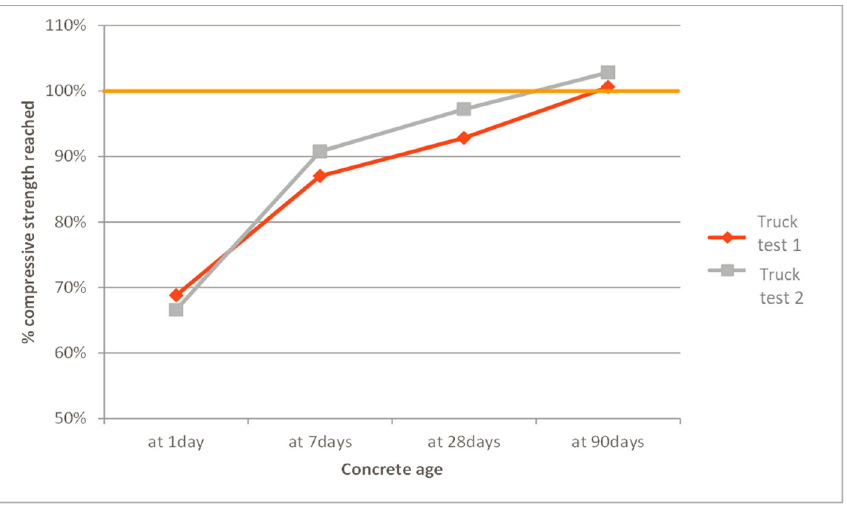
Figure 10. Relative compressive strength of the pilot plant scale insulating refractory concrete